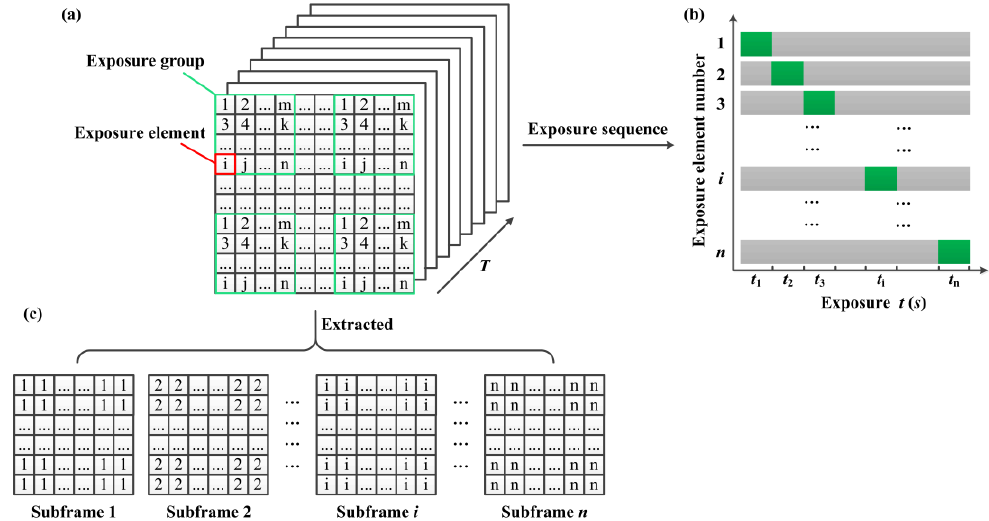
Figure 4. Working principle of per-pixel coded exposure. ( a ) DMD mask; ( b ) Exposure sequence for different exposure elements; ( c ) Subframes.